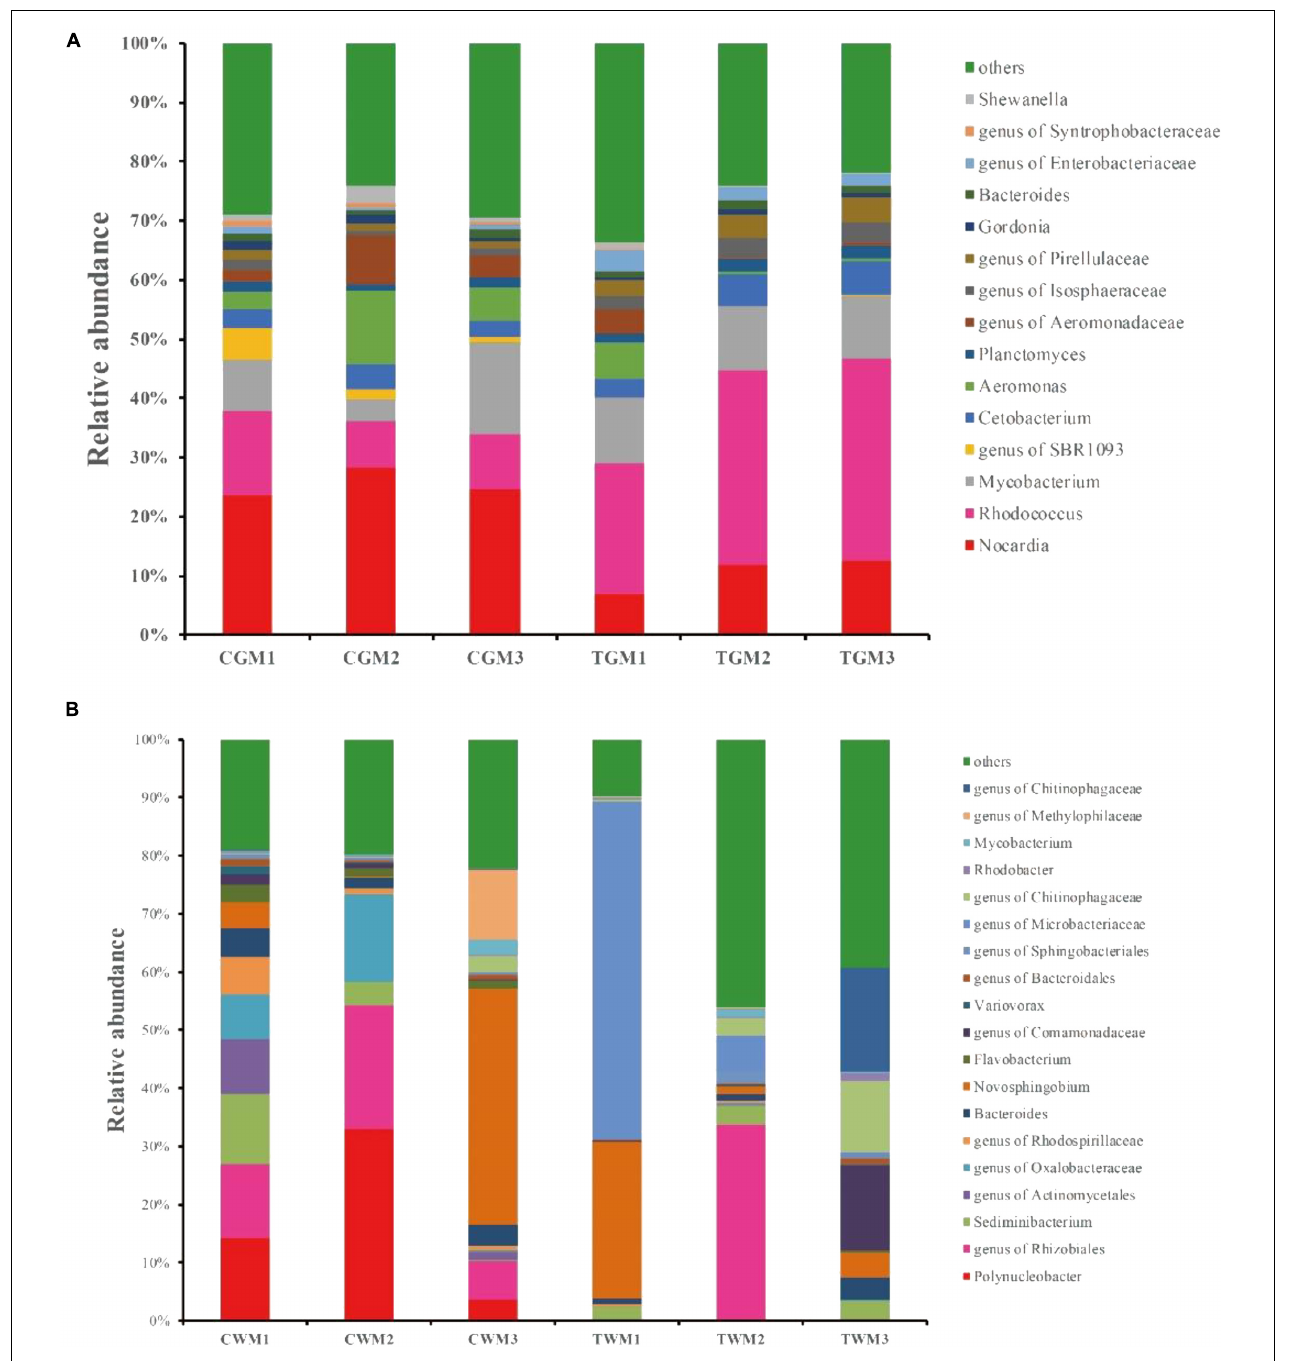
FIGURE 4 | Bacterial composition of the different communities of the dominant genera present in the zebrafish gut (A) and water (B) among different treatments (4 months exposure). Categories with relative abundance < 1% were clustered into “Other.”